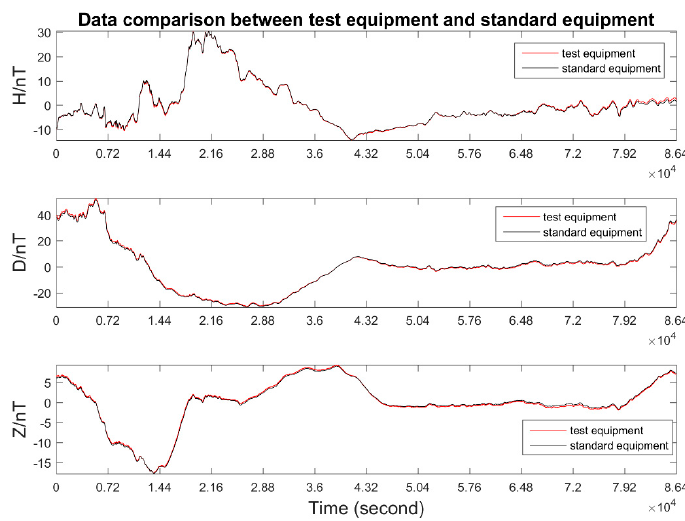
Figure 13. Daily variational curves of the test device and standard